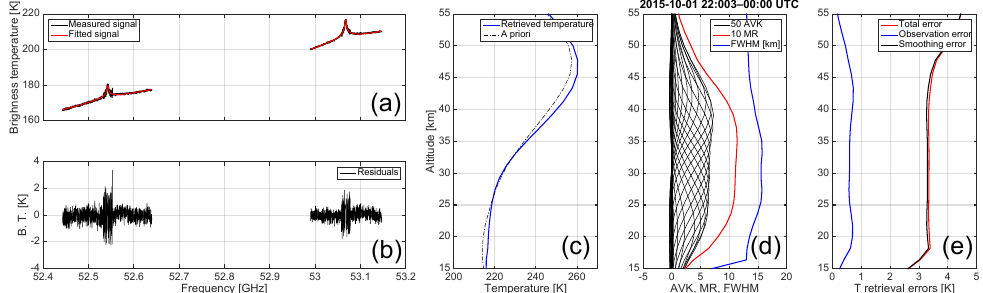
Figure 4. Temperature retrieval of 1 October 2015 using the optimal estimation method (OEM). (a) Brightness temperature measured with TEMPERA (black lines) compared with the forward model brightness temperature (red lines) obtained for this retrieval. (b) Residuals for this inversion. (c) Retrieved temperature and a priori profile. (d) AVKs, measurement response and FWHM (km). (d) Temperature retrieval